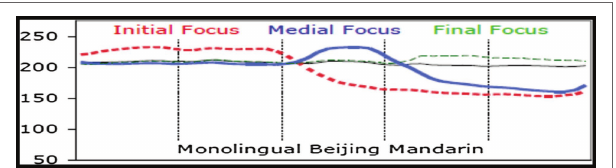
FIGURE 1 | Time-normalized mean F0 contours produced by Mandarin speakers. The vertical lines represent syllable boundaries. The horizontal thin black line represents the no-focus condition, while the colored-lines represent focus conditions in different sentence positions (adapted from Xu,